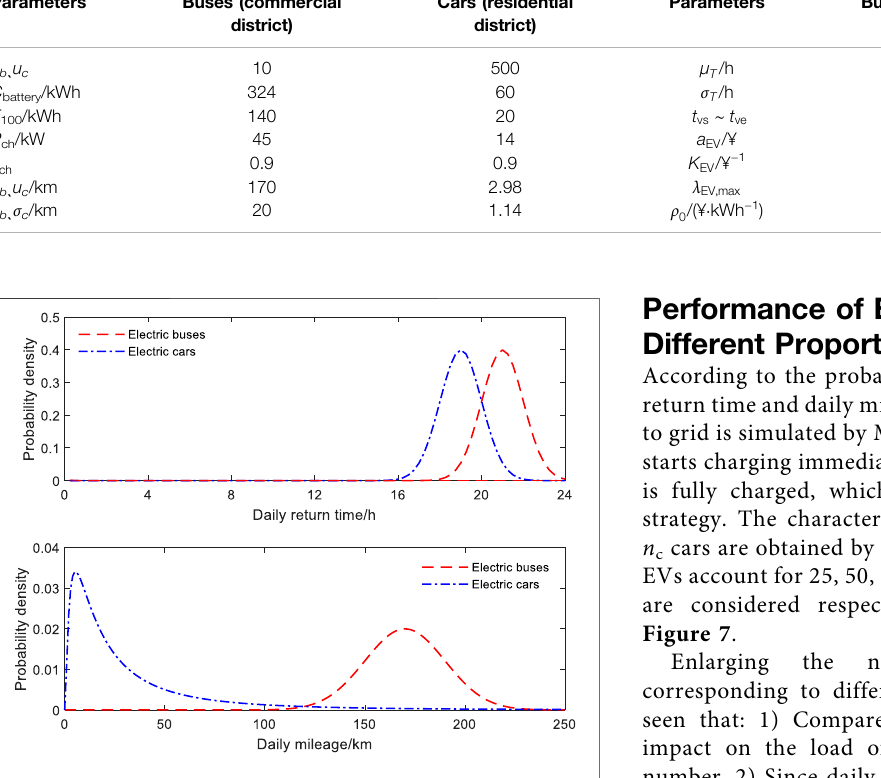
FIGURE 6 | Probability distribution. (A) Daily return time. (B) Daily